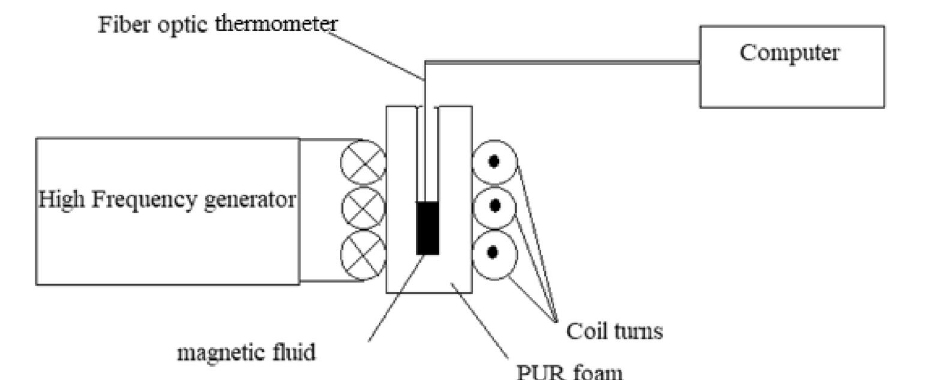
Figure 3. Scheme of the set up used for the measurement of the specific loss